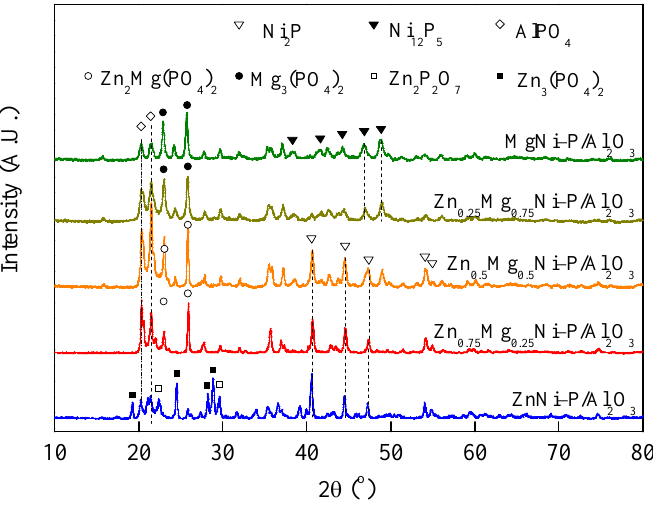
Fig ure 2. XRD patterns of Zn x Mg 1– x Ni–P/Al 2 O 3 . Figure 2. XRD patterns of Zn x Mg 1 − x Ni–P/Al 2 O 3 . Table 2. Textural characteristics of ZnNi–P/Al 2 O 3 , Zn 0.75 Mg 0.25 Ni–P/Al 2 O 3 , and MgNi–P/Al 2 O 3 .